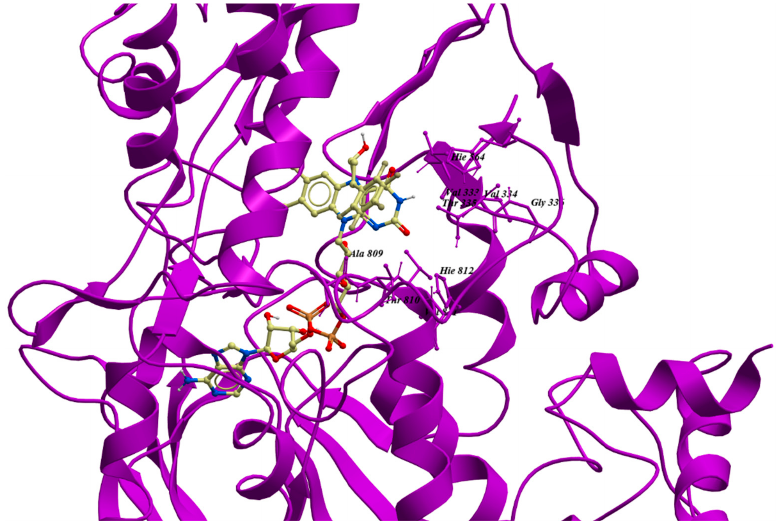
Figure 3. The structure of binding pocket of LSD1 with 2-PFPA. The image was generated